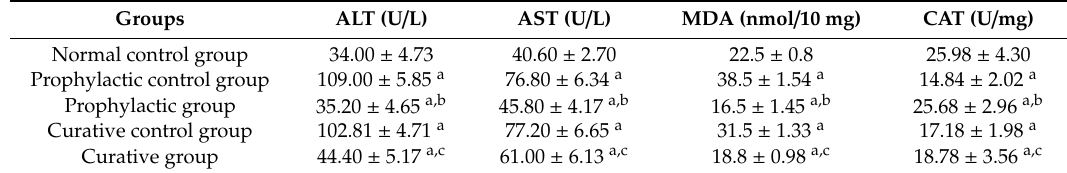
Table 1. E ff ect of Berberis vulgaris root extract ( Bv RE) on cisplatin-induced hepatotoxicity and on liver tissue oxidative status. Serum alanine transaminase (ALT) and serum aspartate aminotransferase (AST) levels were measured in units per liter (U / L), while liver tissue malondialdehyde (MDA) and catalase (CAT) were measured in nmol / 10 mg and U / mg of protein,